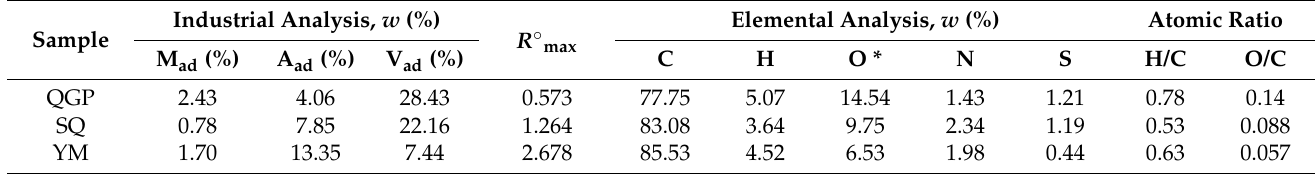
Table 4. Industrial Analysis and elemental analysis of coal